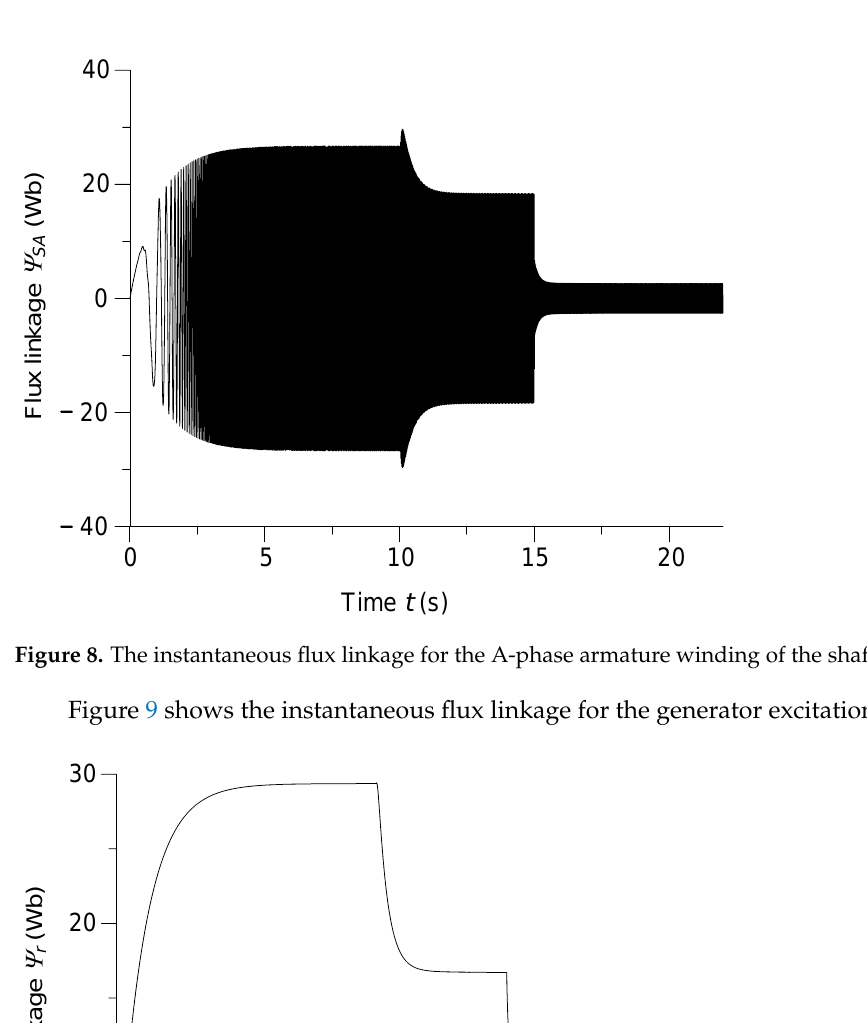
Figure 8. The instantaneous flux linkage for the A-phase armature winding of the shaft generator.